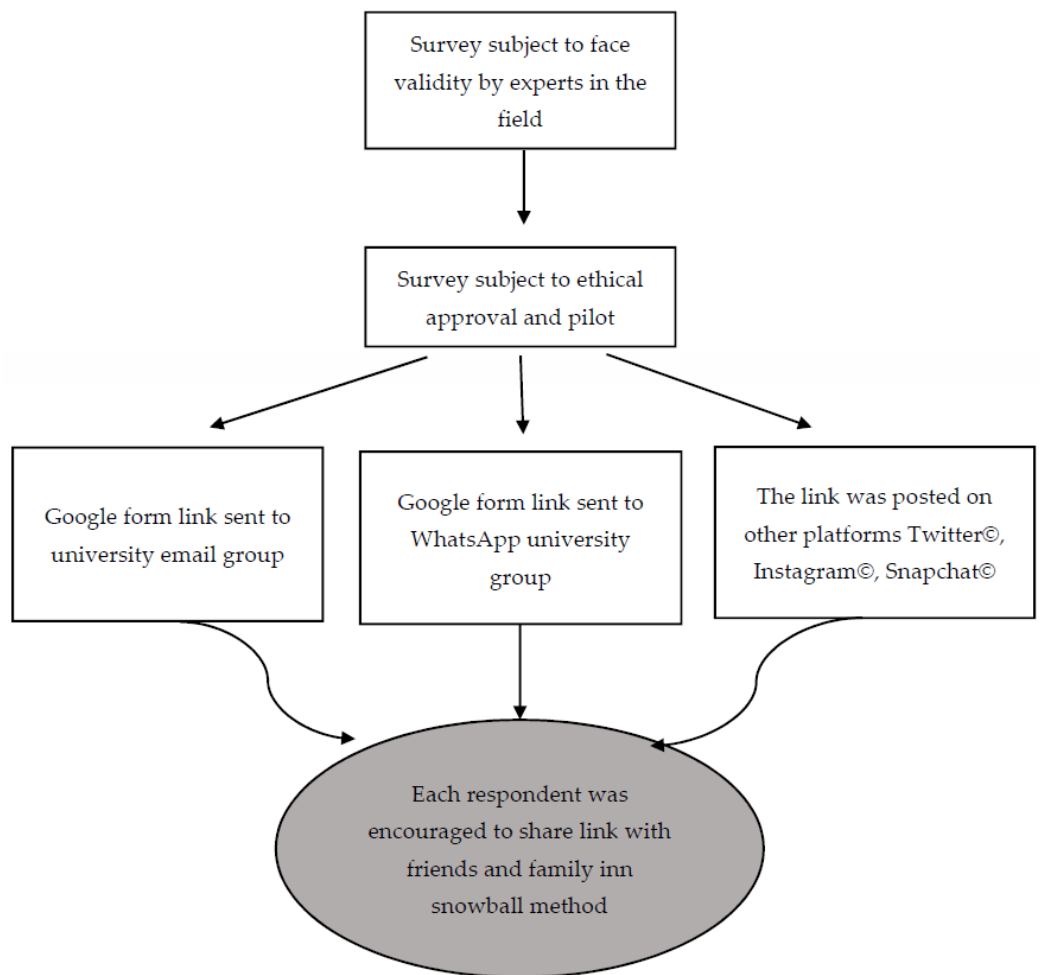
Figure 1. Flow diagram of the methodology.